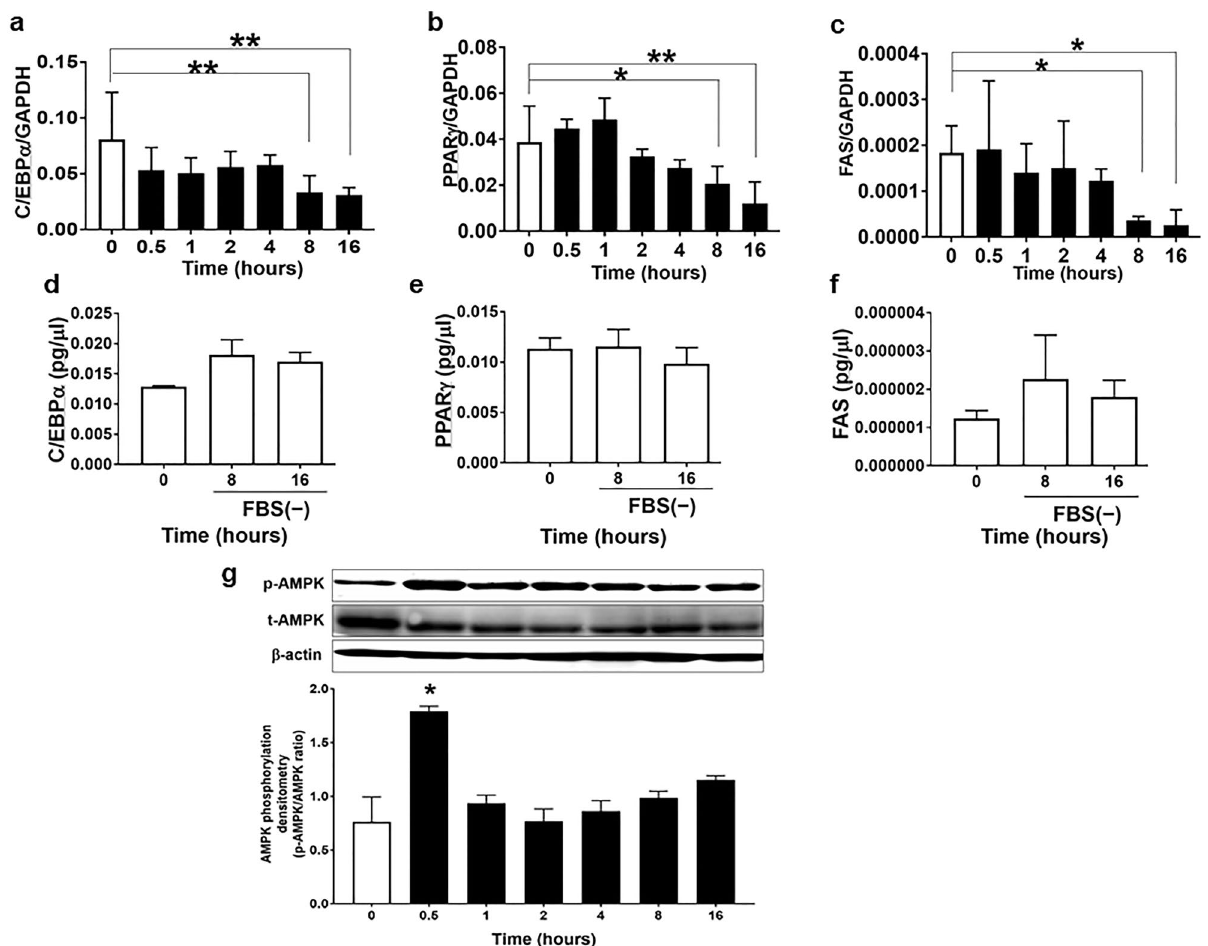
Figure 3. Cinnamon extract (CE) regulates lipogenesis marker expression in a time-dependent manner in 3T3-L1 adipocytes. ( a – d ) 3T3-L1 adipocytes were serum-starved for 8 h and then exposed to 30 μg/mL of CE for another 0.5–16 h. Real-time PCR was employed to determine mRNA expression of ( a ) C/EBPα, ( b ) PPARγ, and ( c ) FAS relative to GAPDH. Each value represents the mean ± SD of three different experiments (n = 3/ group). * p < 0.05, ** p < 0.01, compared with the control values. ( d – f ) 3T3-L1 adipocytes were serum-starved for 8 h and then maintained in serum-free culture for another 8–16 h. Real-time PCR was employed to determine the mRNA expression of ( d ) C/EBPα, ( e ) PPARγ, and ( f ) FAS. Each value represents the mean ± SD of three different experiments (n = 3/group). ( g ) 3T3-L1 adipocytes were serum-starved for 8 h and then exposed to 30 µg/mL of CE for another 0.5–16 h. The level of AMPK phosphorylation was measured via western blotting using total AMPK as loading controls. The image is a cropped blot and the full-length images of the western blot for the three experiments are provided in Supplementary Fig. S2b. In some images, different parts of the same membrane were cut out and reacted with different antibodies. The cutouts are clearly distinguished using yellow separator lines. Each value represents the mean ± SD of three different experiments (n = 3/group). * p < 0.05, compared with the control